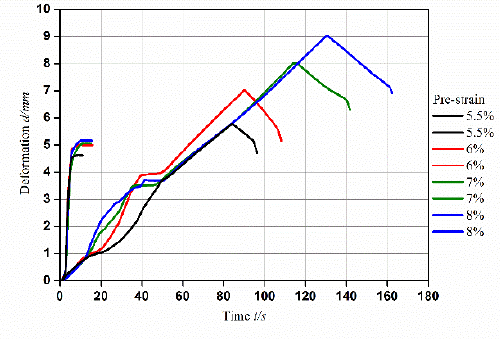
Figure 4. Maximum recovery strain curves.